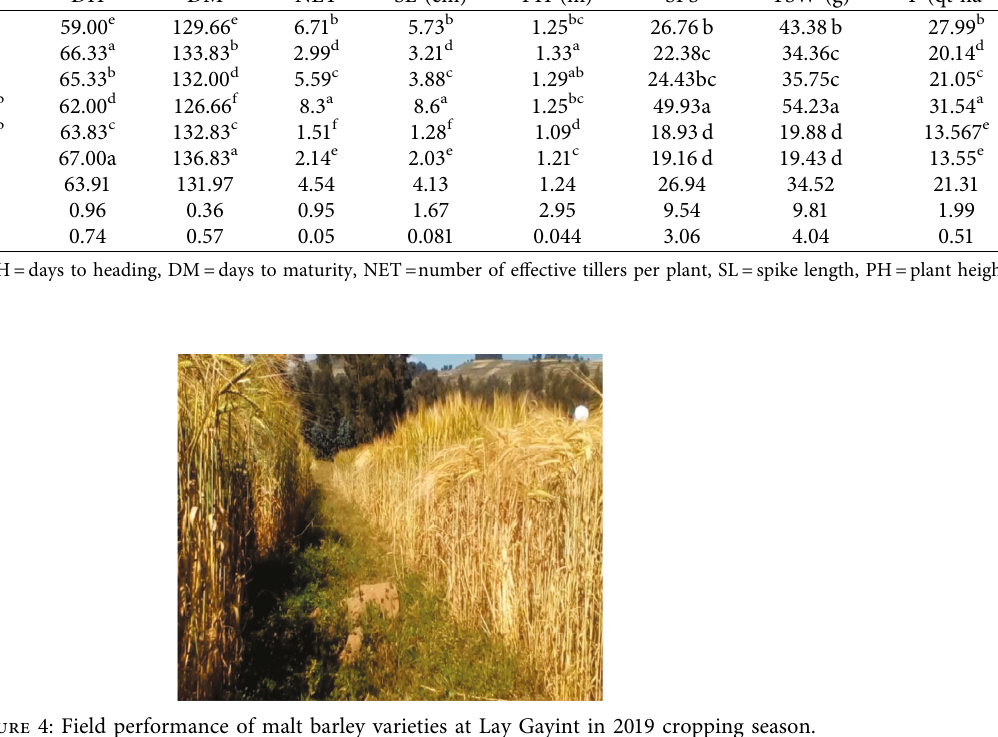
Table 4: The interaction effect of varieties with years on yield and yield components of barley in the 2019 and 2020 cropping season. Trait a Variety